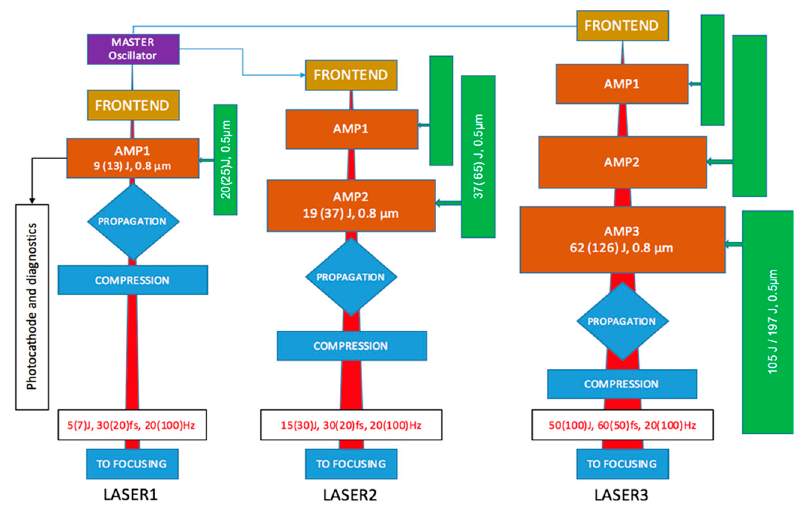
Figure 1. Block diagram of the three laser chains.